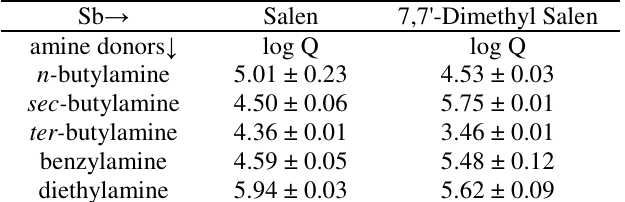
Table 1. The logarithmic equilibrium quotients for [Co(Sb)(PPh amine donors in acetonitrile